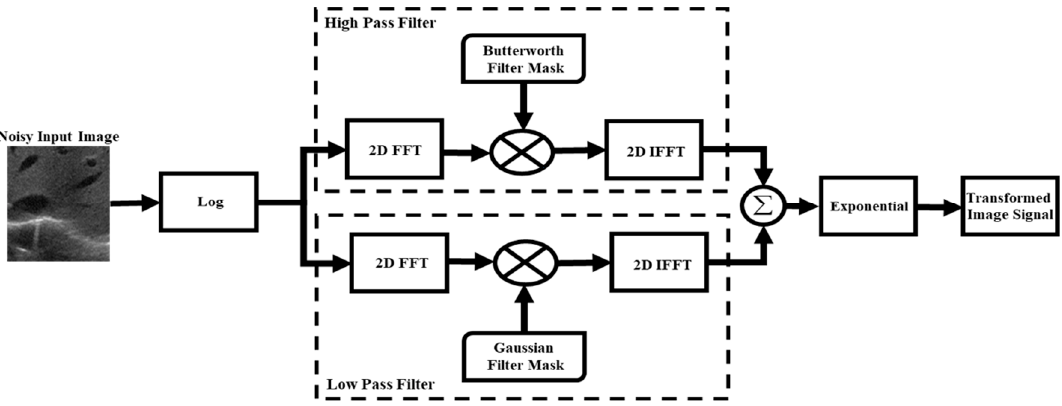
Figure 1. Flow diagram of the enhanced homomorphic filter. FFT: fast Fourier transform; IFFT inverse fast Fourier transform.